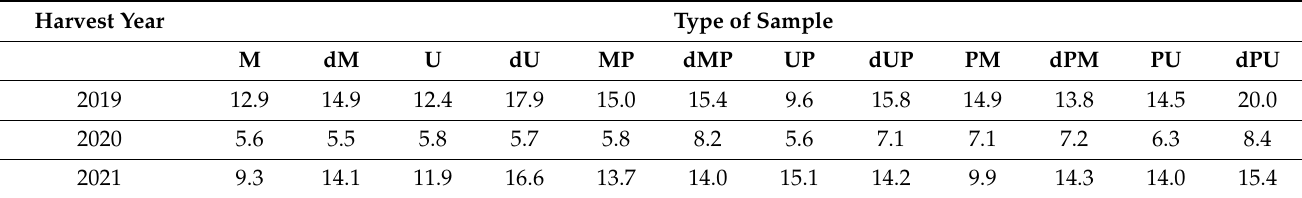
Table 4. Anti-radical activity of the analyzed samples.